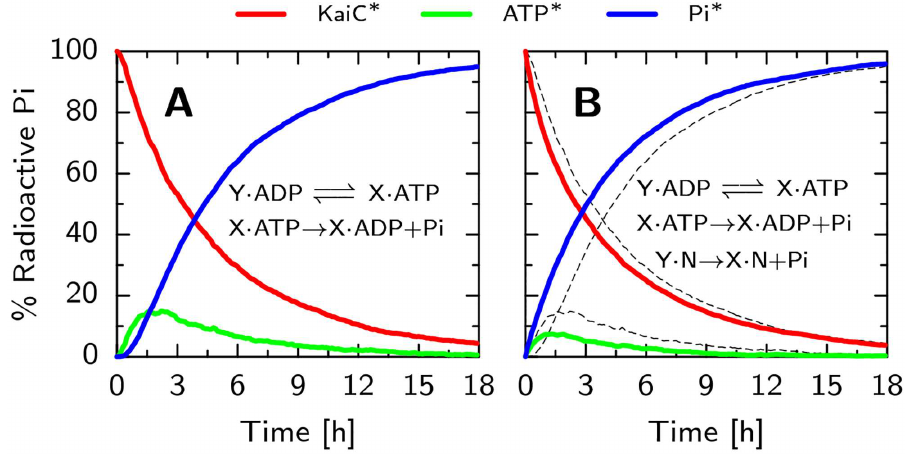
Fig 7. Phosphotransfer between KaiC and ADP is the dominant pathway during dephosphorylation of KaiC. Initial conditionsare the same as in Fig 6A, but now the phosphate groupsare ‘radioactive’ such that they can be tracked from their initial positionon the KaiC (KaiC * ,red line), to the radioactive ATP (ATP * , green line) and in solution (Pi * , blue line). PanelsA show time traces of this dephosphorylationassay for our model, while panel B shows the results for an alternativemodel in which spontaneousdephosphorylation is also possible(for comparison, the results of our model, presented in panelA, are shownas thin dashedlines). In our model, panel A, dephosphorylationcan only occur via the transfer of the phosphategroup on KaiC to the ADP in the CII nucleotidebindingpocket. The alternativemodel, panel B, represents a scenariowith two dephosphorylationpathways: one via the transfer to ADP, and one via direct exchangewith the bulk. We chose rates such that dephosphorylation occurs equallythrough both pathways, and the total dephosphorylationspeedis similar to our model (panelA). Comparingwith the radioactivephosphate tracking experiment in [28], Fig 2, shows that the scenario where dephosphorylationcan only occur via ADP (panelA) agreesbest with the data. In particular, the onset of the free Pi concentration shows a temporaldelay in panel A that is absent in panel B. Furthermore, the level of radioactiveATP is the highestin panel A, which comparesbest to the 20% peak height in